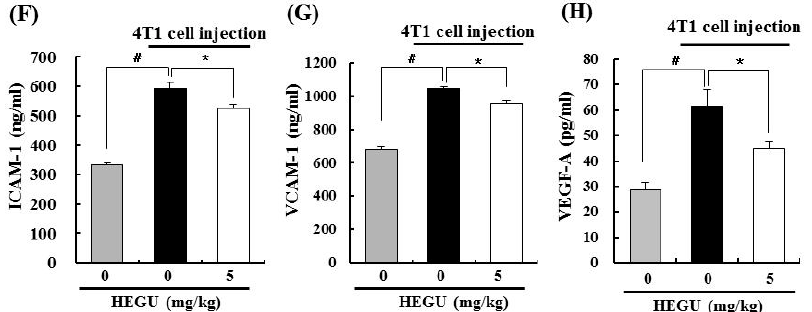
Figure 2. HEGU in drinking water inhibits lung metastasis in BALB/c mice injected with 4T1 cells. Mice were injected with 4T1 cells and treated with HEGU as described in Figure 1. At the end of the experiment, the lungs were excised and fixed in Bouin’s solution. ( A ) Photographs of the lungs, which are representative of 8 normal control animals and 20 tumor-bearing animals. Tumor nodules can be observed on the surface of the lungs; ( B ) the number of tumor nodules in the lungs; ( C ) lung weight; ( D – H ) blood samples were collected from the mice at the time of sacrifice, and the sera were